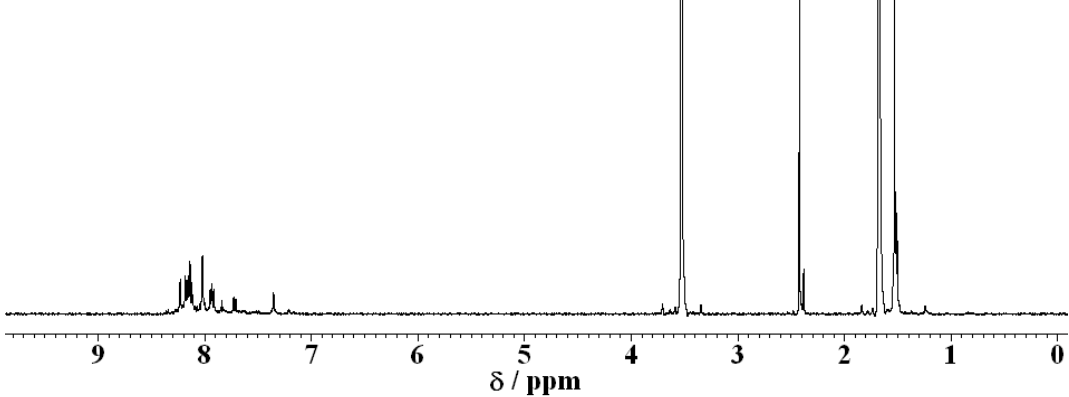
Figure S1. 1 H-NMR spectrum of 2,2 ′ ,7,7 ′ -tetrakis(7- tert -butyl-1-pyrenyl)-9,9 ′ -spirobi [9H- fluorene] ( 4-PySBF , 400 MHz, THF-d 8